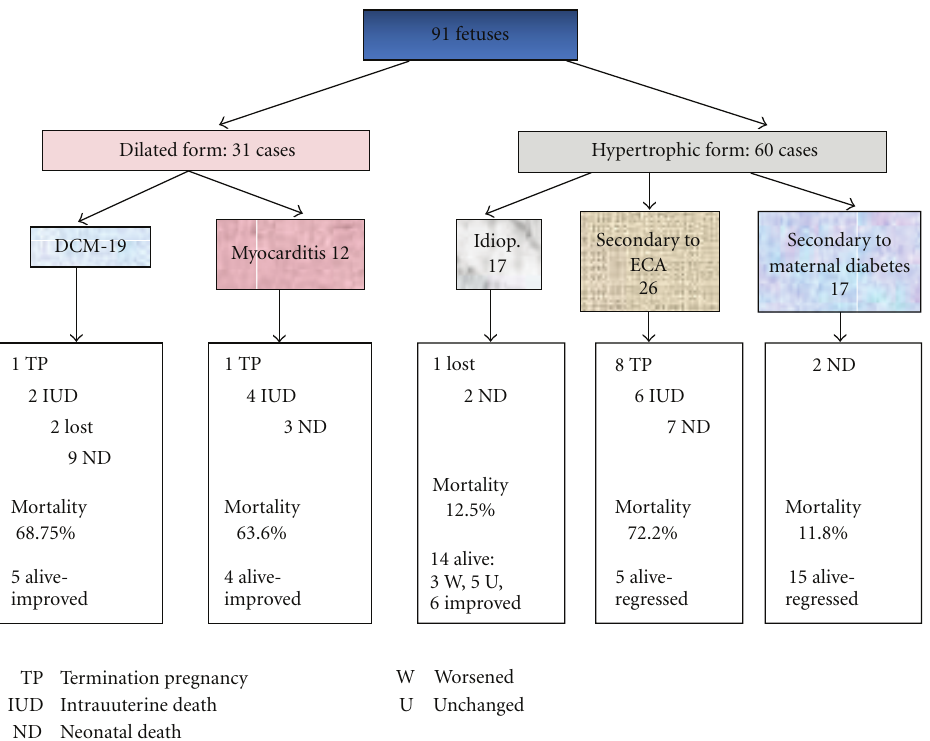
Figure 3: Flow chart summarizing the frequency and the outcomes in the di ff erent forms of myocardial disease.